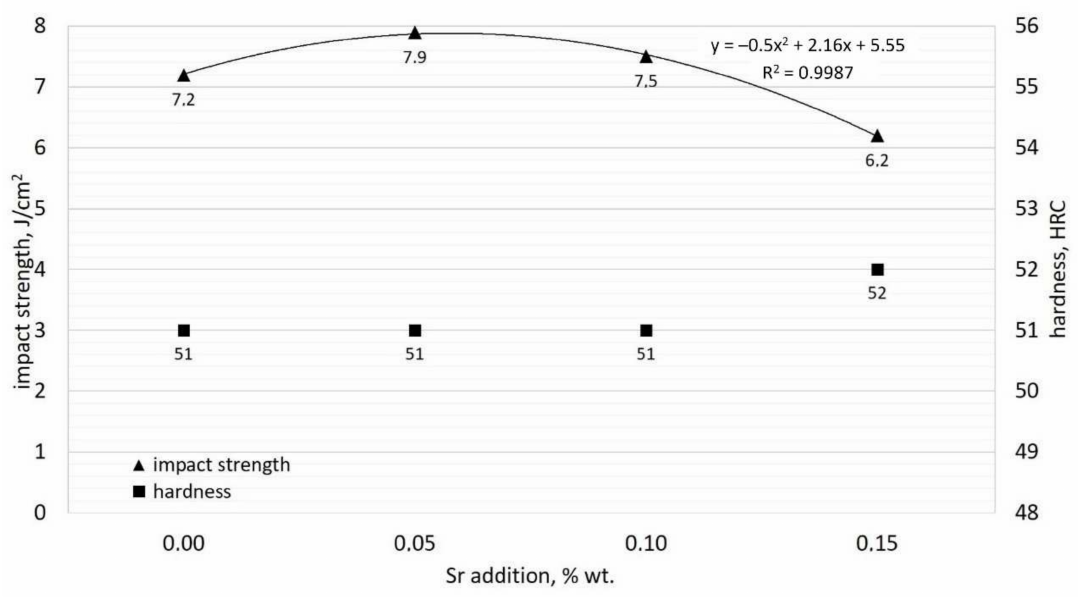
Figure 9. Influence of Sr addition on impact strength and hardness of examined